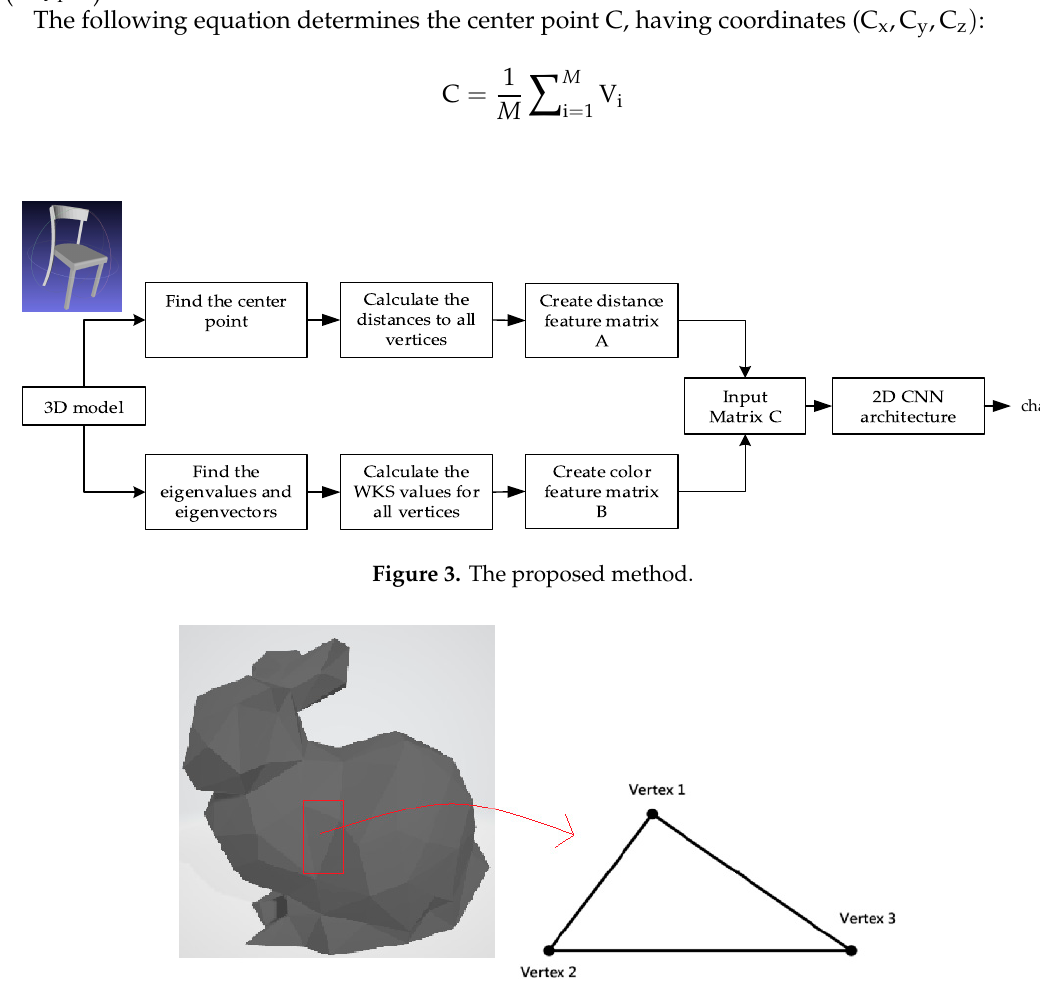
Figure 4. Three vertices and one face extract from 3D triangle mesh.